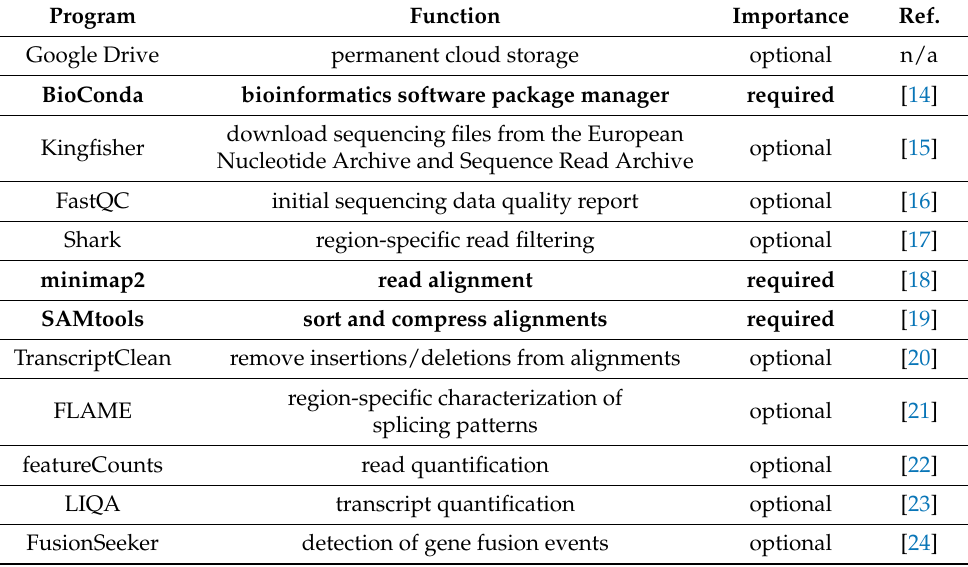
Table 1. Individual programs incorporated into L-RAPiT and their